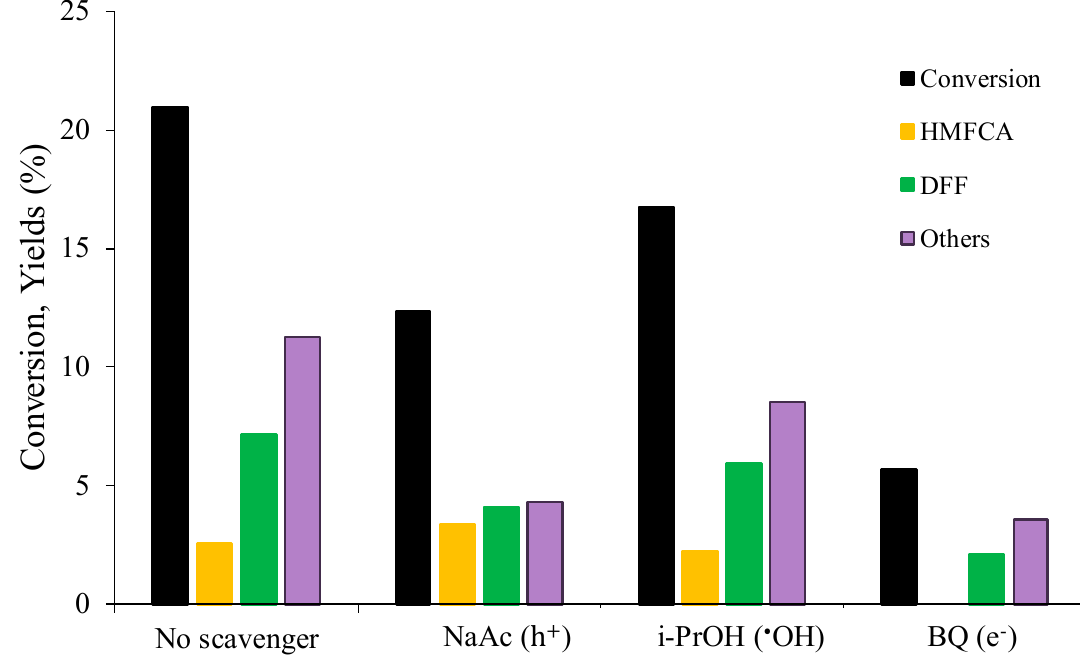
Figure 10. Photocatalytic performance of Au 3 Cu 1 /Ti 15 Si 85 SFD in presence of different scavengers. NaAc: Sodium Acetate; i-PrOH: 2-Propanol; BQ: BenzoQuinone. Reaction conditions: t = 1 h, T = 30 °C, P = 1 atm O 2 , m cat = 20 mg, V = 20 mL, [HMF] 0 = 5 × 10 − 4 mol/L, [Scavenger]/[HMF] = 9.